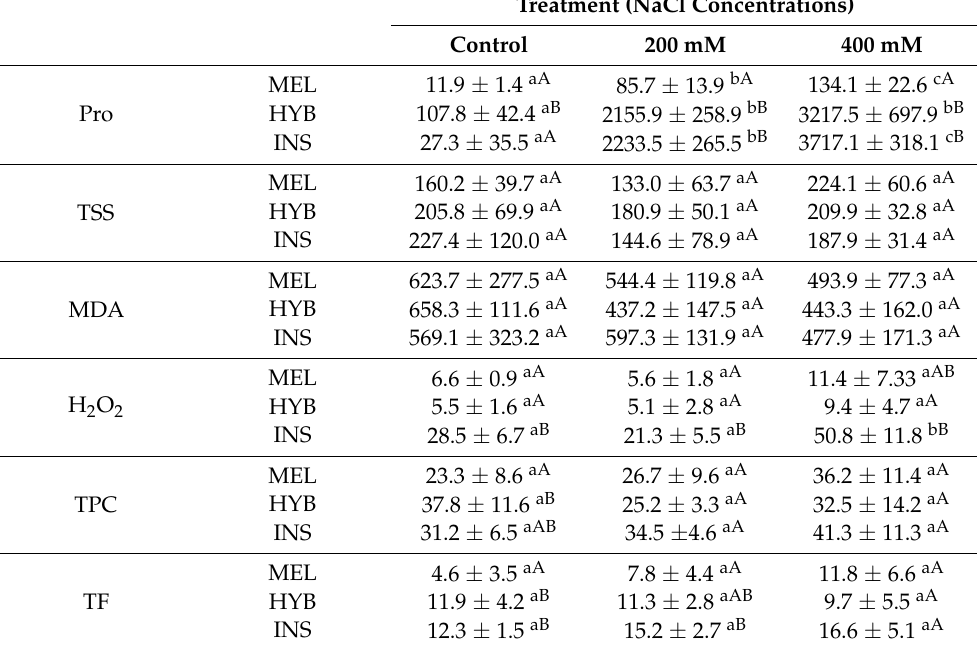
Table 4. Proline (Pro) ( µ mol g − 1 dry weight), total soluble sugars (TSS) (mg equiv. glucose g − 1 dry weight), malondialdehyde (MDA) (nmol g − 1 dry weight), hydrogen peroxide (H 2 O 2 ) ( µ mol g − 1 dry weight), total phenolic compounds (TPC) (mg equiv. gallic acid g − 1 dry weight), and total flavonoids (TF) (mg equiv. catechin g − 1 dry weight) values (mean ± SD; n = 5) in Solanum melongena